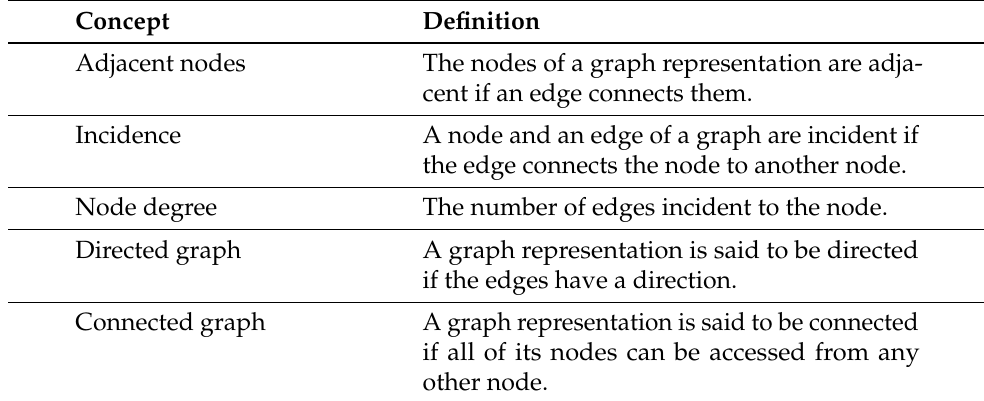
Figure 2. An abstract depiction of a heterogeneous graph representation of spatial entities. The triangles represents buildings, circles represents streets, parallelograms represents natural bodies. The relations between the entities is defined using relations such as the spatial within , spatial intersects , spatial adjacent . Table 2. Graph theory concepts and